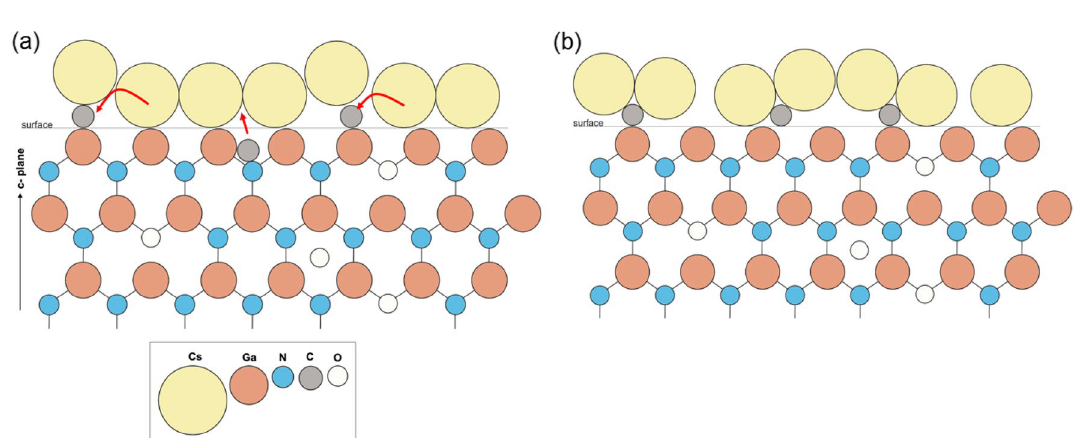
Figure 7. ( a ) The surface model of a freshly prepared p-GaN:Cs photocathode. The surface C attracts a part of the Cs and ( b ) the surface model of an aged p-GaN:Cs photocathode showing the formation of Cs x C y